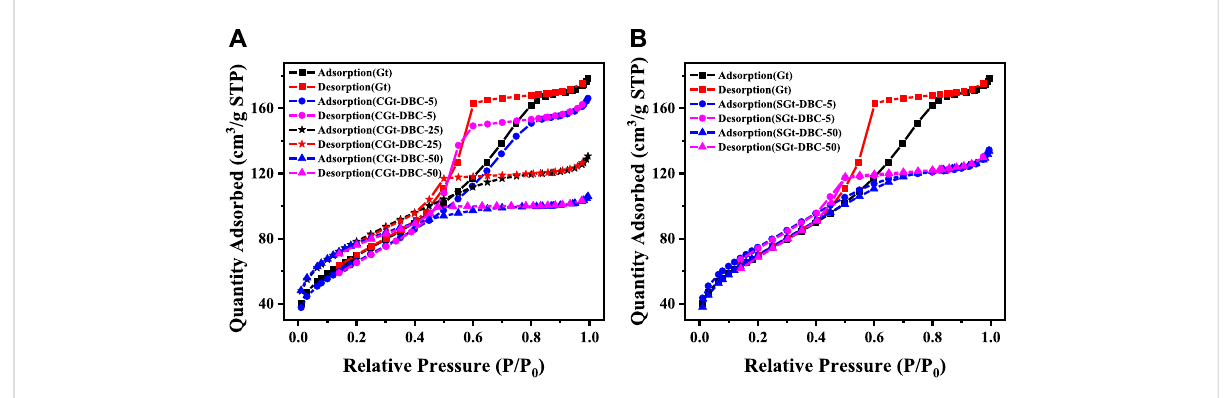
FIGURE 3 Nitrogen adsorption-desorption isotherms of Gt and (A) CGt-DBC and (B) SGt-DBC samples (CGt-DBC, the coprecipitated Gt-DBC complexes; SGt-DBC, the adsorbed Gt-DBC complexes; Numbers indicate the additive concentration of DBC in the preparation of Gt-DBC